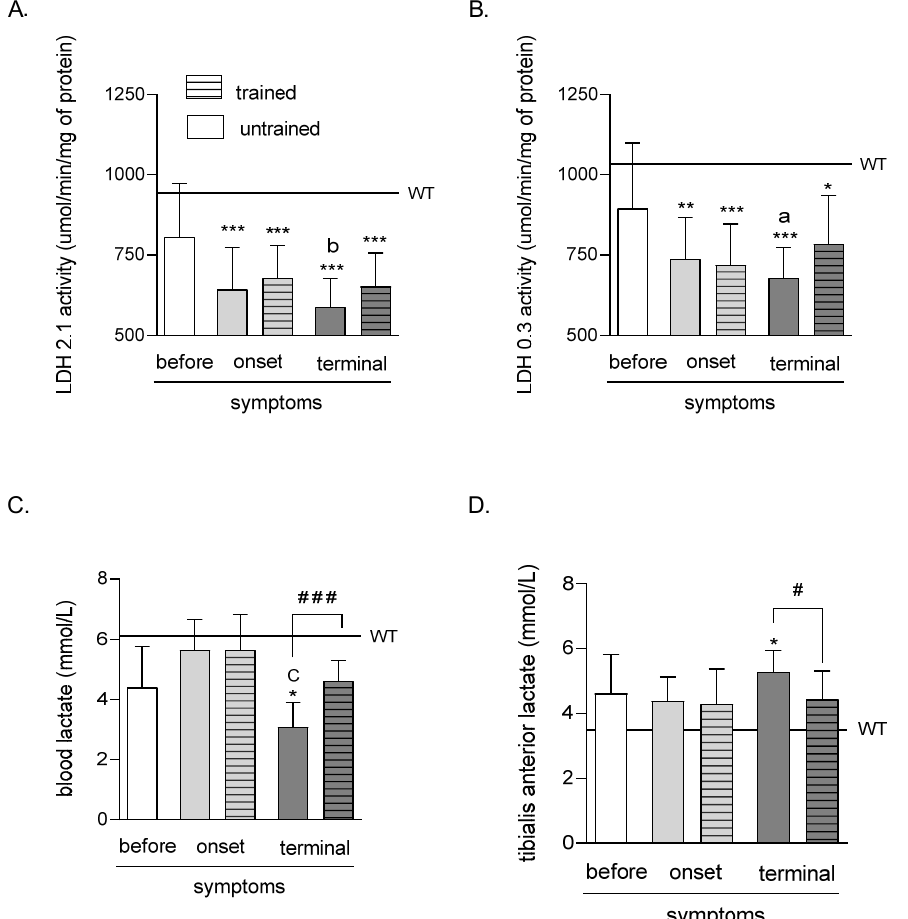
Figure 1. Effects of ALS disease progression and swim training on skeletal muscle LDH 2.1 and LDH 0.3 activities and skeletal muscle and blood LA concentration. LDH 2.1 ( A ) and LDH 0.3 ( B ) activities were measured in the tibialis anterior muscle of mice; LA concentration was measured in the blood ( C ) and the tibialis anterior muscle of mice ( D ). There were significant differences between the groups: * p < 0.05, ** p < 0.01 and *** p < 0.001 vs. WT group of mice, a p < 0.05 and b p < 0.01 vs. BEFORE group, C p < 0.001 vs. ONSET group (Tukey’s post-hoc test), # p < 0.05 and ### p < 0.001 between indicated group (Student’s t -test). The data are presented as the means ± SEM ( n = 7 in each